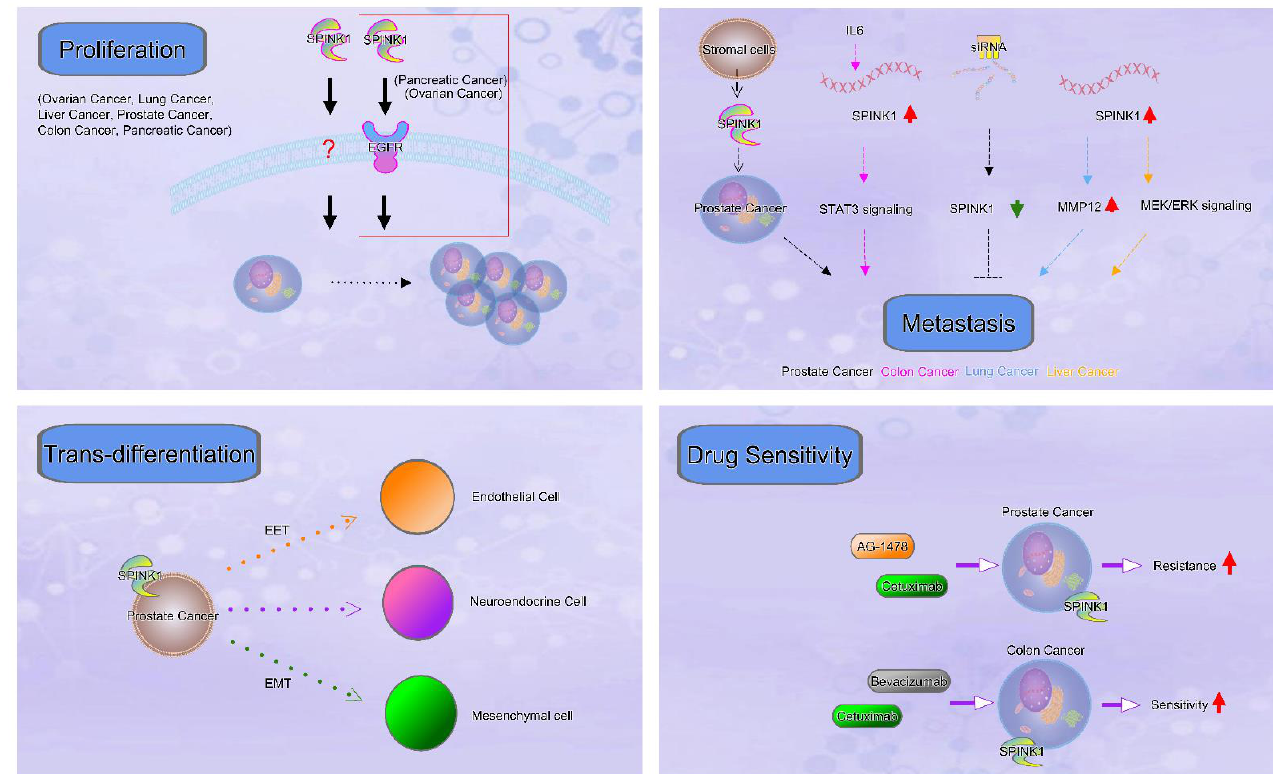
Figure 4. The representative scheme of SPINK1 in cancer progression was shown. Funding: This study was funded by Chang Gung Memorial Hospital, Linkou (CMRPG3J1411, CMRPG3J1412, CMRPG3J1413) and the Ministry of Science and Technology (1072314-B-182A-158- MY3), Taiwan.